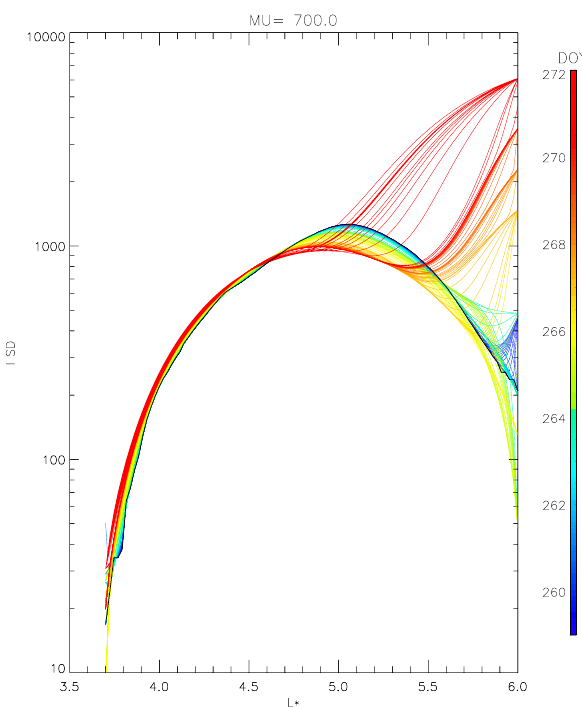
Figure 10. Time development of phase space density from a simu- lation using the radial coefficient of Brautigam and Albert